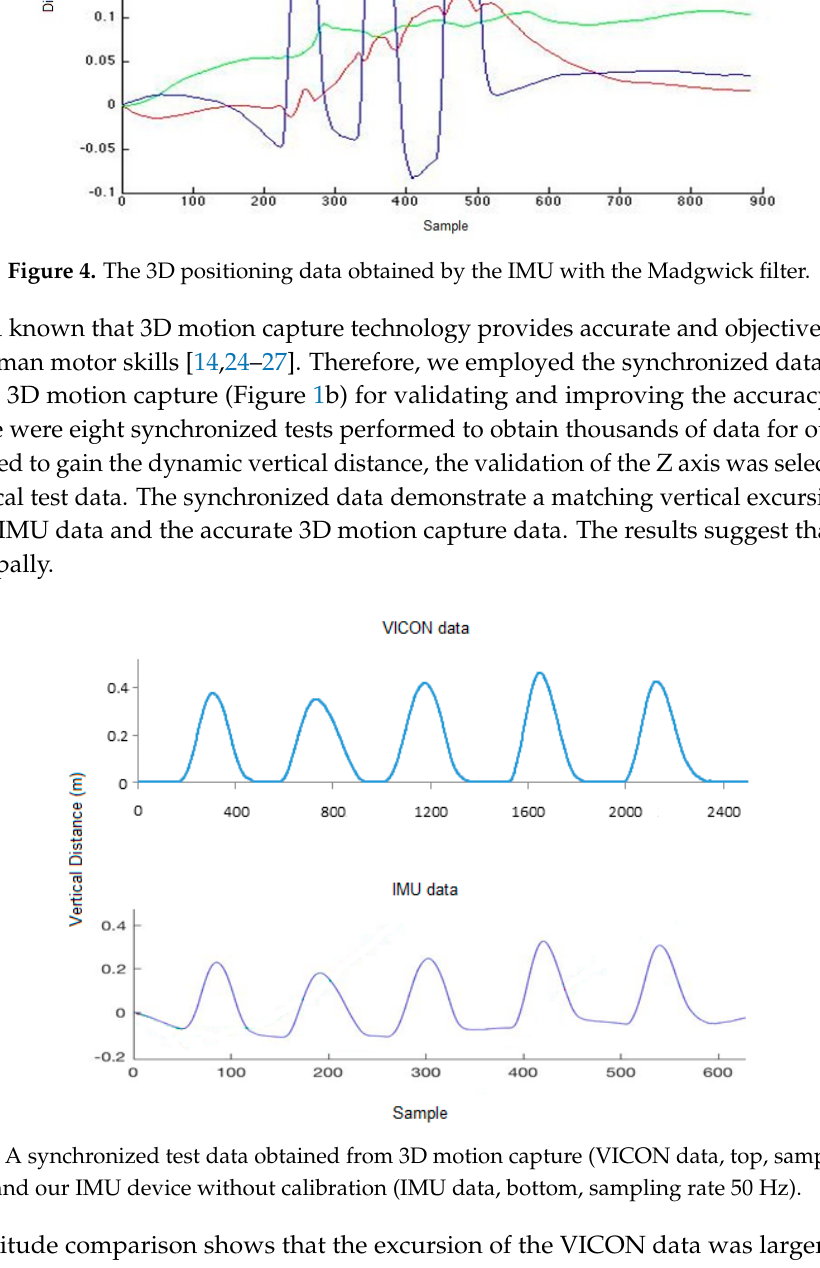
Figure 4. The 3D positioning data obtained by the IMU with the Madgwick filter.